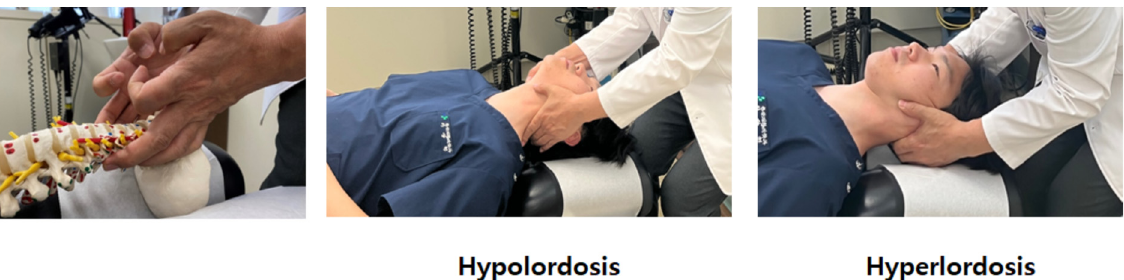
Figure 2. Supine position cervical distraction. After checking hyperlordosis or hypolordosis. Set the angle and segment according to the patient and traction toward to head. For example, IF hyperlordosis, lifting both sides of the C4 articular process and traction 45 degrees toward to head.